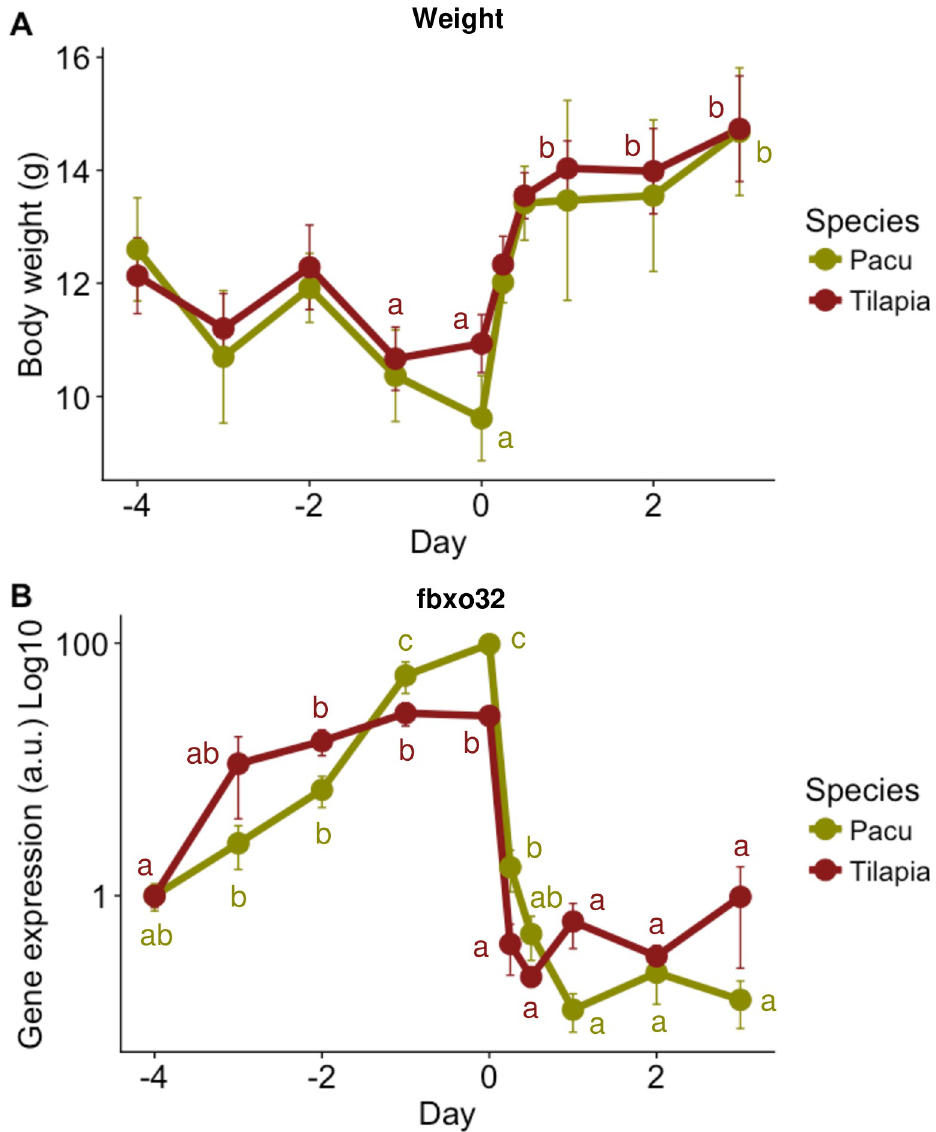
Fig 1. Response to fasting-refeeding protocol in pacus and Nile tilapias. (A) Evolution of total body weight (g) in pacu (green line) and tilapia (red line) juveniles during 4 days of fasting (-4 to 0 day) and 3 of refeeding (0 to 3 day). Values are shown as Mean ± SE (n = 6), different letters indicate significant differences between time points for each species (P < 0.05). (B) Relative gene expression of F-box protein 32 ( fbxo32 ) in pacu and tilapia fast skeletal muscle in response to fasting-refeeding expressed in Log10 scale. Values are shown as Mean ± SE (n = 6), different letters indicate significant differences between time points for each species (P < 0.05).